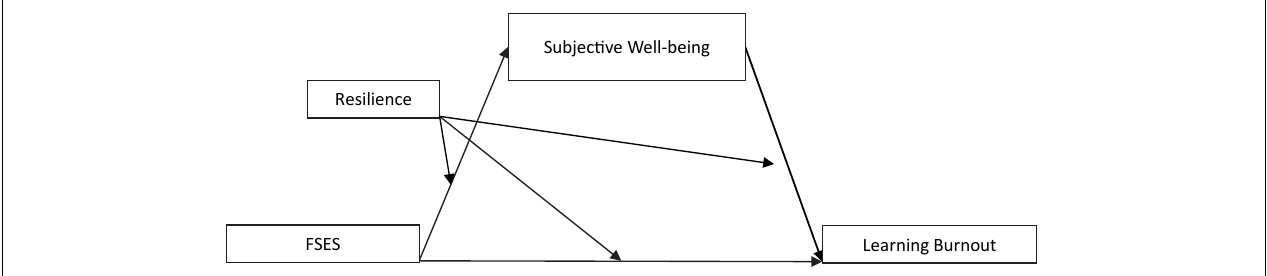
FIGURE 1 | Moderated mediation model regarding perceptions of FSES and learning burnout, mediated by subjective well-being and moderated by resilience.